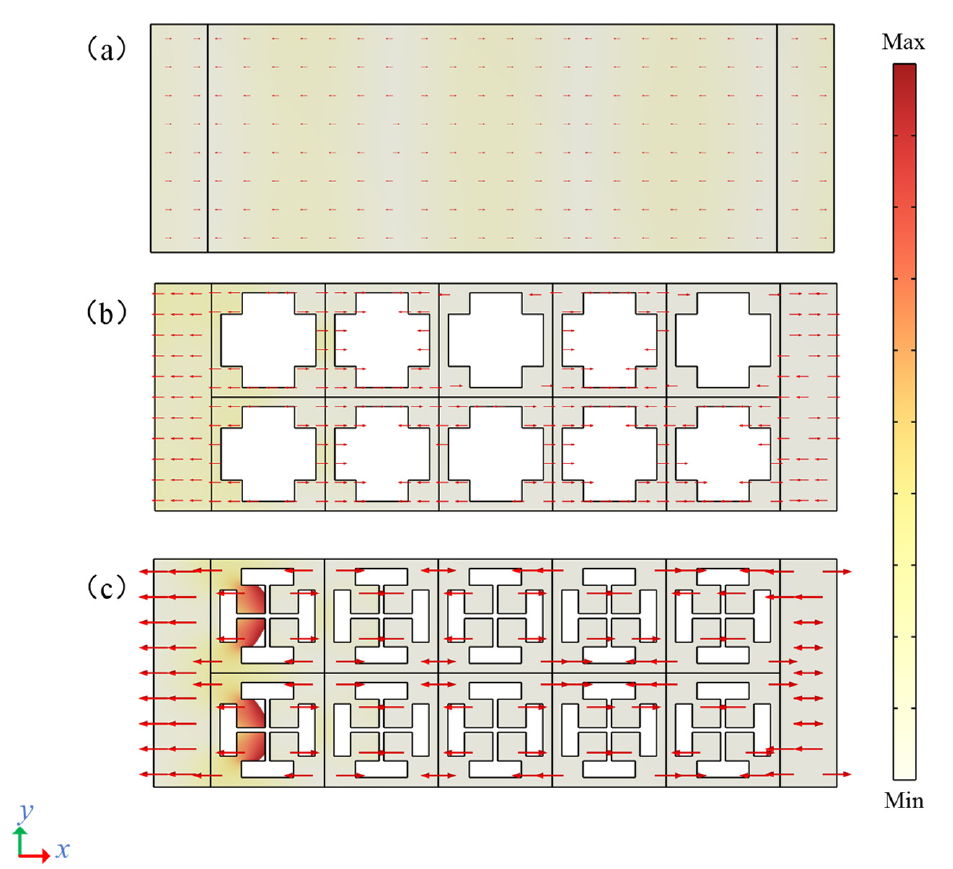
Figure 6. Normalized displacement field of the delay line model at 108 MHz. ( a ) Solid contrast delay line, ( b ) cross-shaped delay line, ( c ) DIH-PnC delay line.